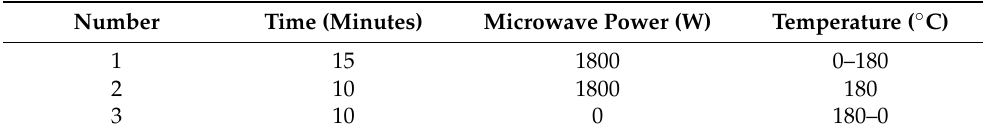
Table 1. Work program of microwave digestion system.